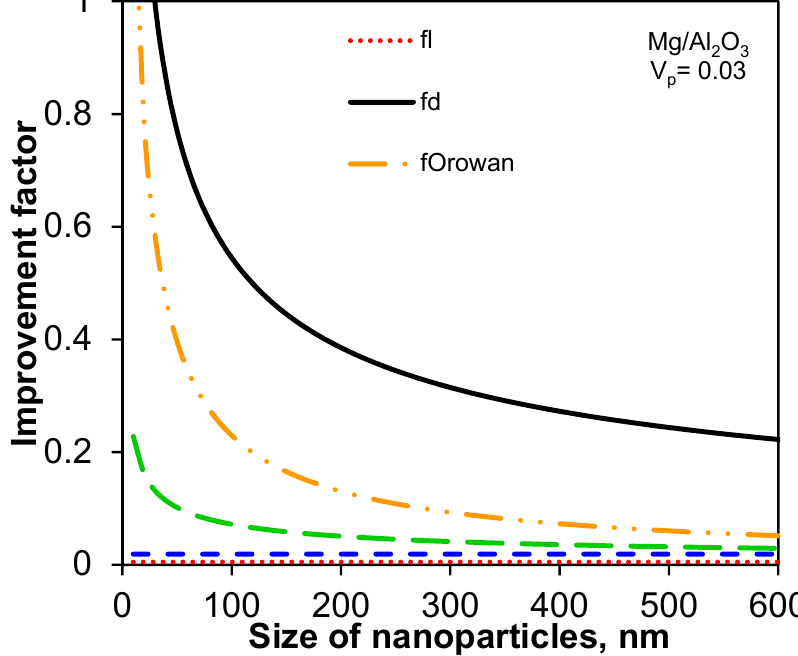
Figure 2. The improvement factors as a function of nanoparticle size with a volume fraction of 0.03 and 0.01 for nanoparticles and porosity, respectively, in Mg/Al 2 O 3